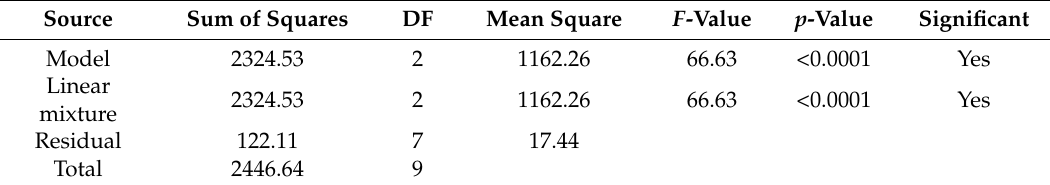
Table 7. ANOVA results for coefficient of viscosity Burgers model ( η 1 ).